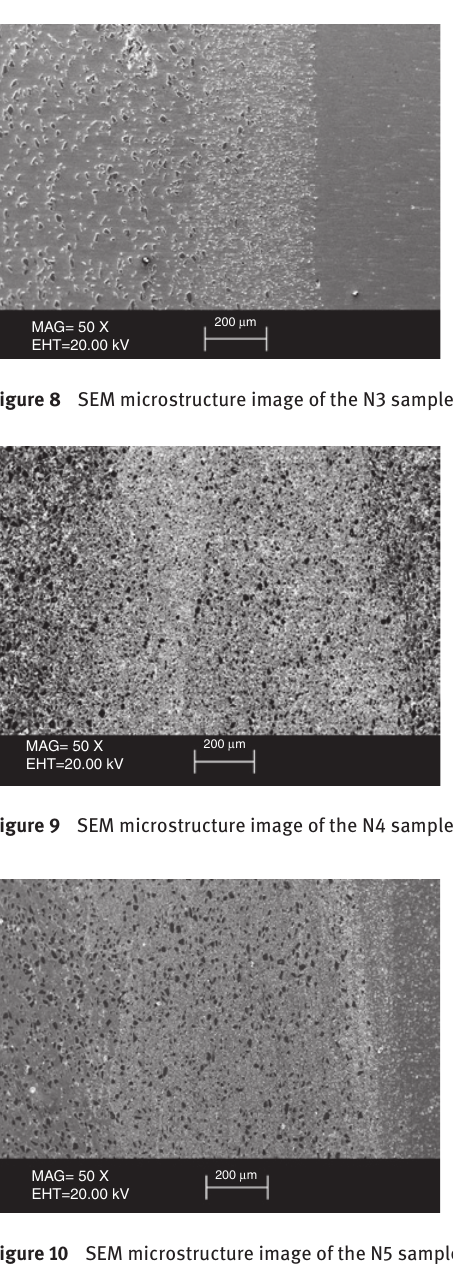
Figure 10 SEM microstructure image of the N5 sample.